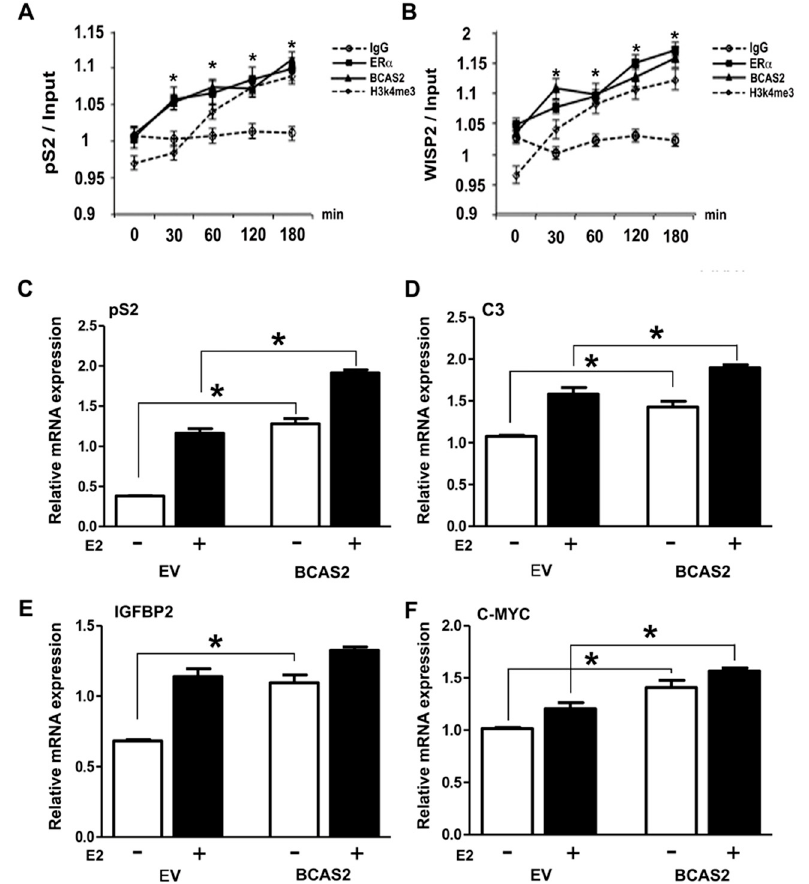
Figure 3. BCAS2 colocalizes with ER α on estrogen regulated promoters upon incubation with E2 and promotes increased estrogen-regulated gene expression. ( A , B ) Chromatin immunoprecipitation was